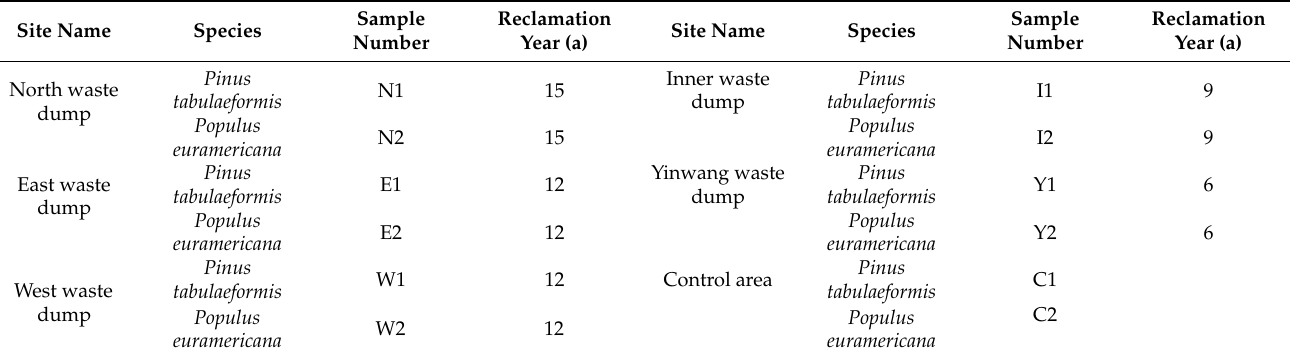
Table 1. Information on sampling and control